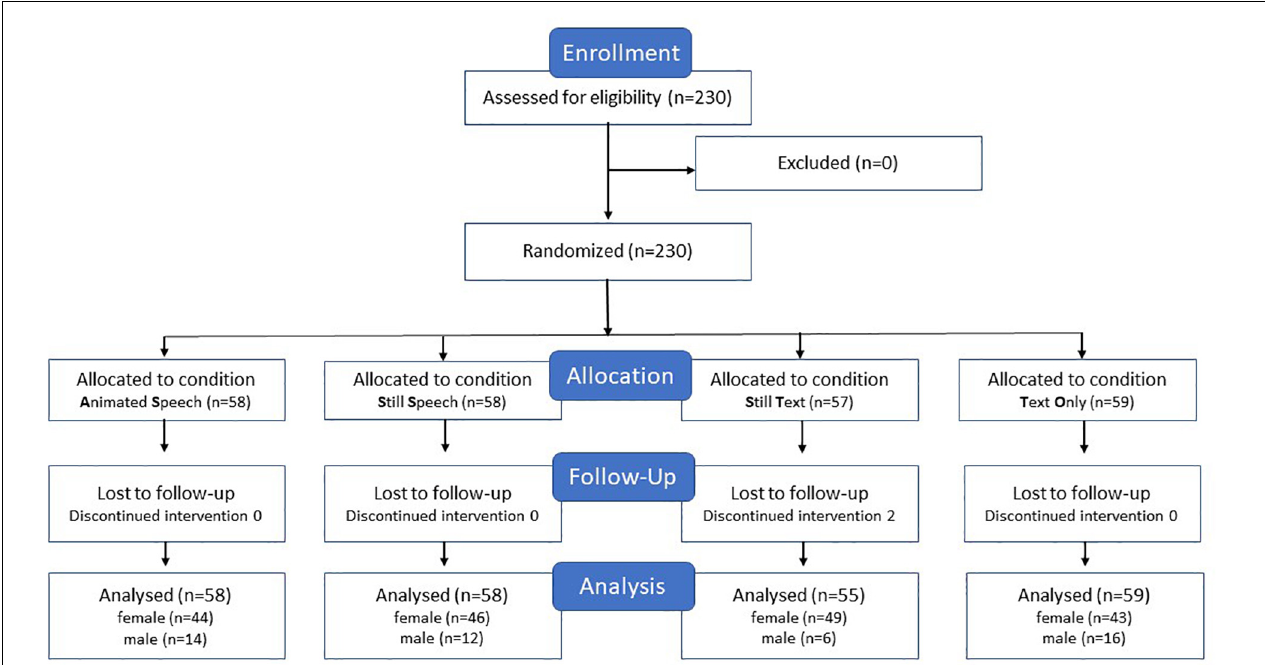
FIGURE 2 | CONSORT flow chart for study